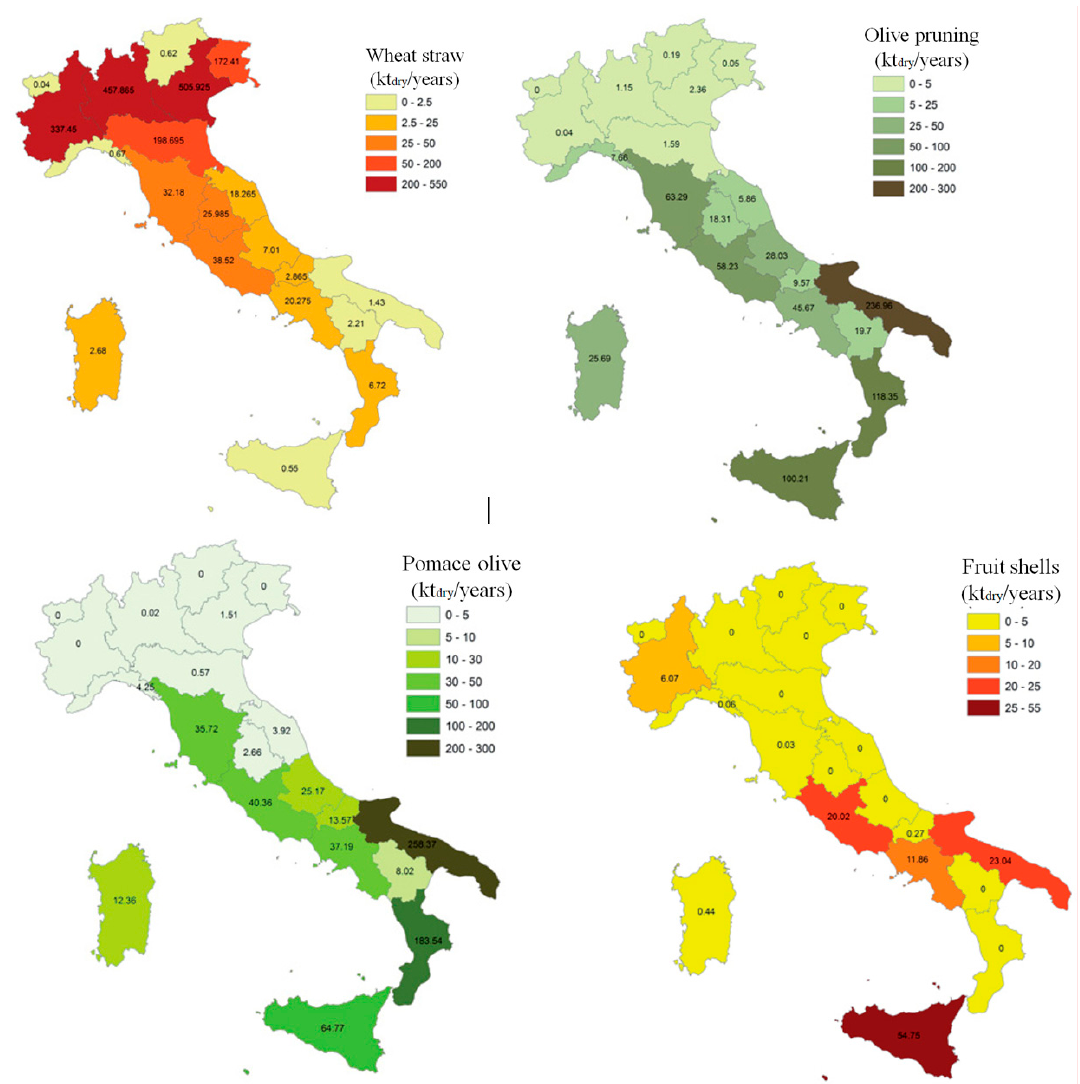
Figure 1. Diffusion of the biomass waste on Italian soil analyzed in this study [43].